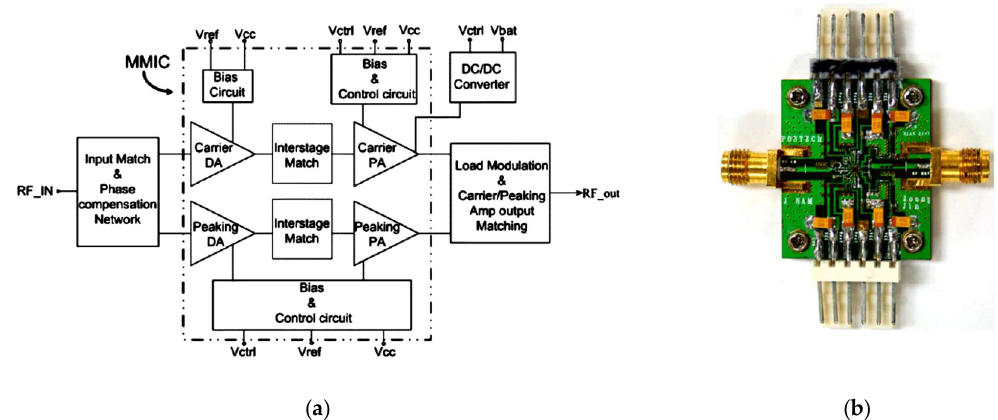
Figure 25. ( a ) MIMIC DPA using dynamic bias control. ( b ) A module of RF power test presented in [131].